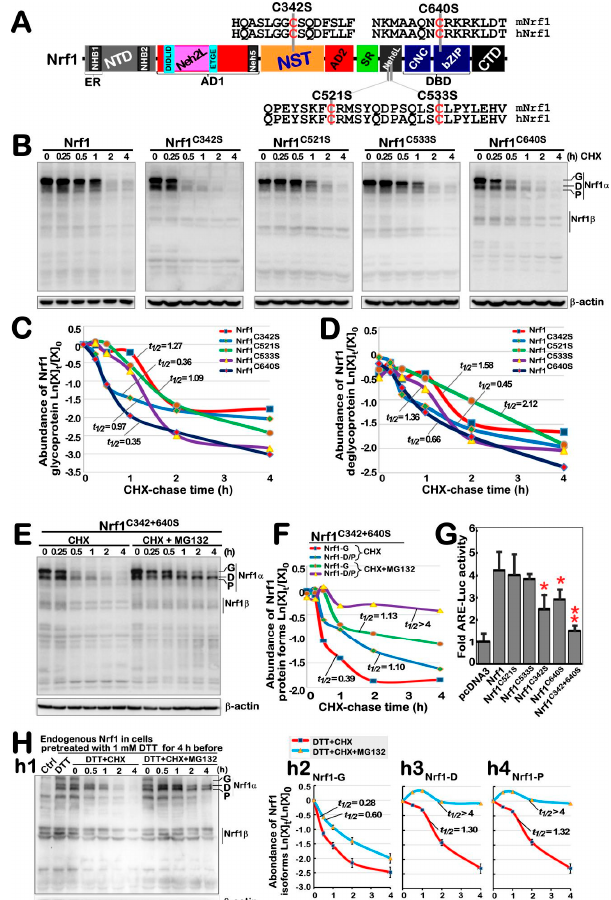
Figure 5. Nrf1 stability and its trans -activity were determined by redox status of its Cys342 and Cys640. ( A ) Schematic diagram of four cysteine mutants within Nrf1, which are distributed in its NST, Neh6L and bZIP domains. ( B ) Stability of Nrf1 and its mutants was determined by the pulse-chase experiments for 0 to 4 h intervention by CHX (50 µ g/mL). ( C , D ) The results were evaluated for the turnover trend of glycoproteins ( C ) and deglycoproteins (including processed proteins) ( D ) of Nrf1 α and mutants, with distinct half-lives estimated. ( E , F ) After treatment of cells with CHX alone or plus 10 µ M MG132, stability of the Nrf1 C342/640S mutant was further examined by pulse-chase experiments ( E ), and distinct half-lives of its derivative proteins were calculated ( F ). ( G ) WT cells were co-transfected with an ARE-Luc reporter, together with each of the indicated expression constructs for Nrf1, its mutants or empty pcDNA3.1 vector. The luciferase activity was normalized to their internal controls and corresponding backgrounds obtained from the co-transfection of cells with non- ARE reporter and each of the expression constructs. The results were calculated as mean ± SD ( n = 6 × 3 ) ( * p < 0.05; ** p < 0.01 ) relative to the basal activity (at a given value of 1.0) obtained from the transfection of cells with empty pcDNA3.1 vector and ARE-driven reporter. ( H ) Stability of endogenous Nrf1 α proteins was examined by pulse-chase experiments after stimulation of cells by 1 mM DTT ( h1 ), and changes in its derived glycoprotein, deglycoprotein, and processed protein abundances were represented by their respective turnover time-course curves ( h2 – h4 ). In addition, similar examinations of ectopically expressing Nrf1 α and its Nrf1 C342/640S mutant after 1 mM DTT stimulation were also shown in Figure S4. The intensity of relevant immunoblots representing different protein expression levels was also quantified by the Quantity One 4.6.2 software. The resulting data were shown graphically, after being calculated by a formula of Ln ([X] t /[X] 0 ), in which [X] t indicated a fold change ( mean ± SD ) in each of those examined protein expression levels at different times relative to corresponding controls measured at 0 h (i.e., [A] 0 ), which were representative of at least three independent